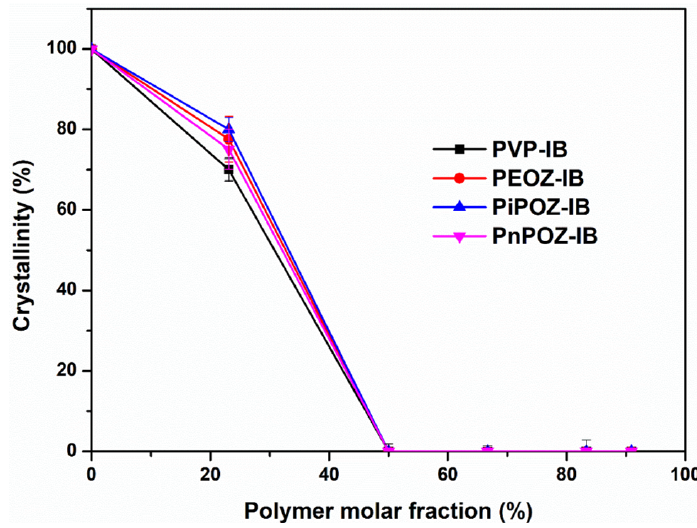
Figure 4. Crystallinity of polymer–IB solid dispersions as a function of polymer molar